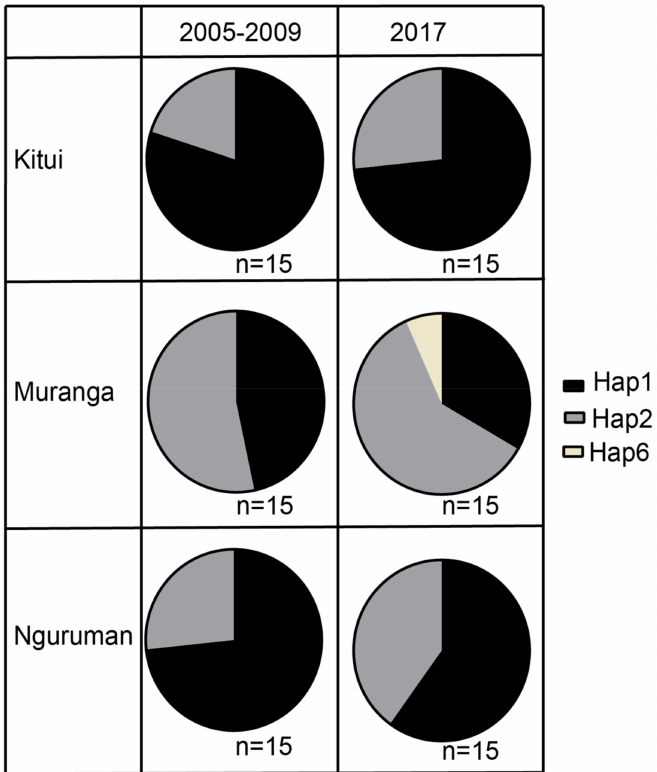
Figure 4. Pie charts depicting haplotype compositions in sites sampled during the period between 2005 to 2009 (left column) and in 2017 (right